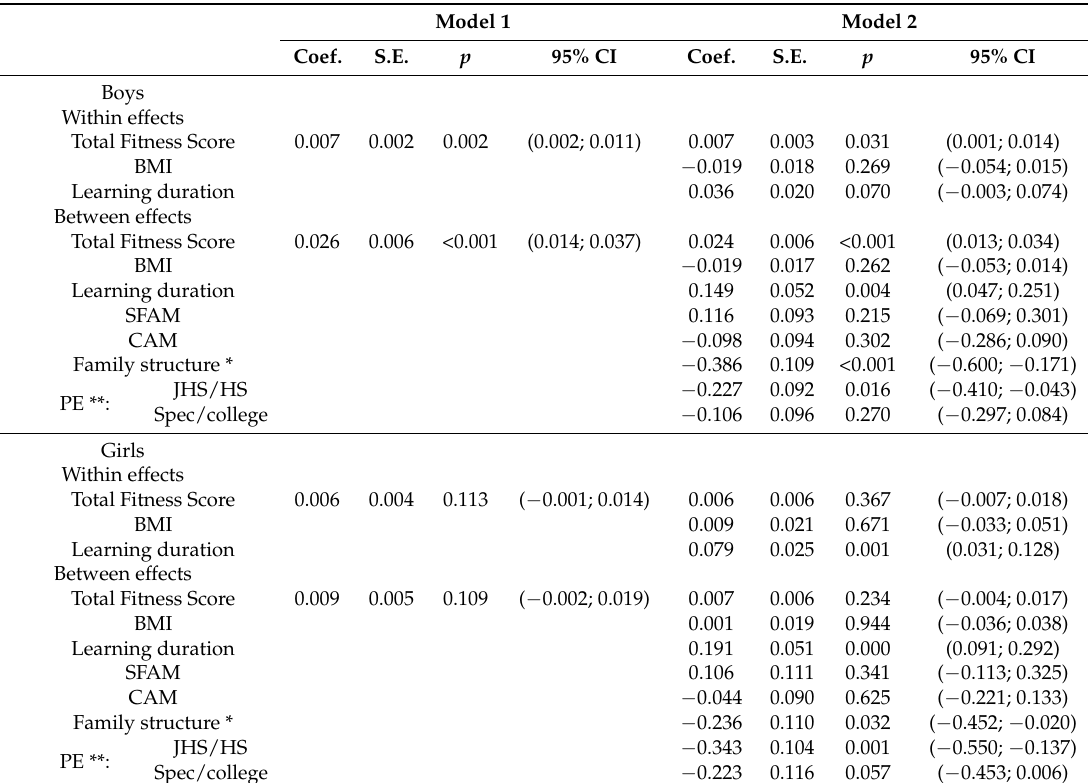
Table 2. Hybrid model predicting the academic achievement using imputed